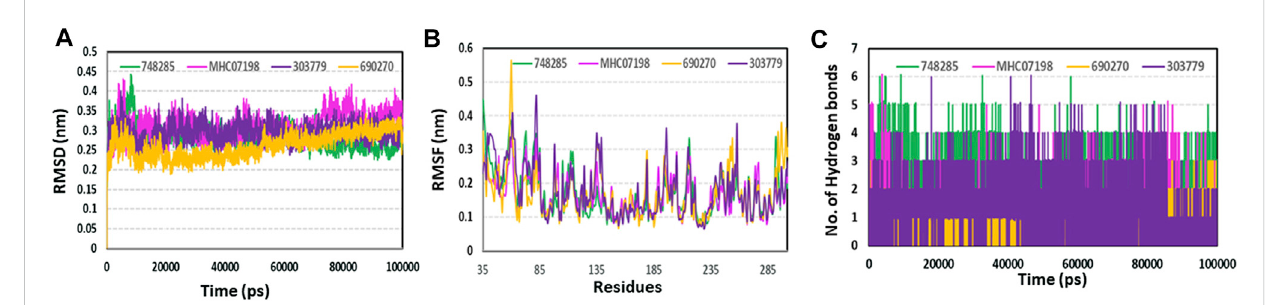
FIGURE 7 Molecular dynamics simulation analyses. (A) RMSD plot; (B) RMSF plot; (C) hydrogen plot for selected compounds to illustrate protein – ligand stability during a 100-ns